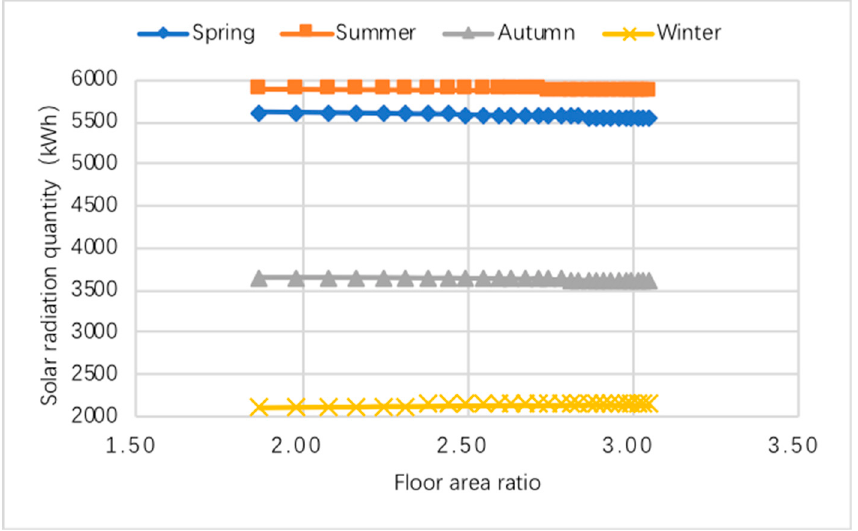
Figure 5. Solar radiation analysis of each season.